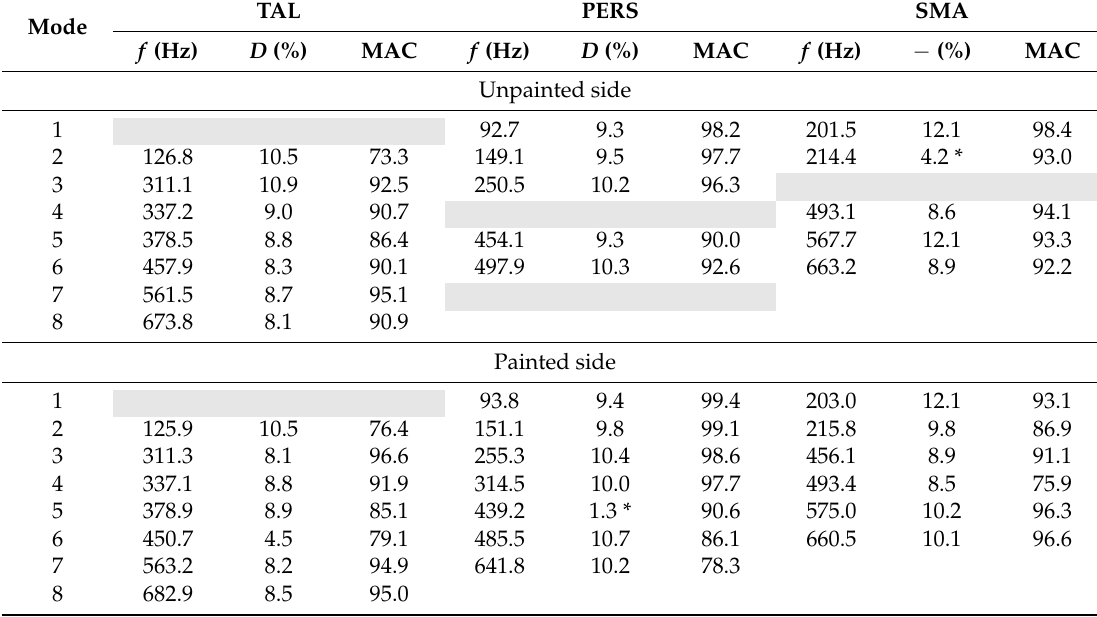
Table 3. Modal parameters of three types of pavement slabs on their two sides (unpainted and painted). The gray rows are mode shapes that Polymax estimate was not able to